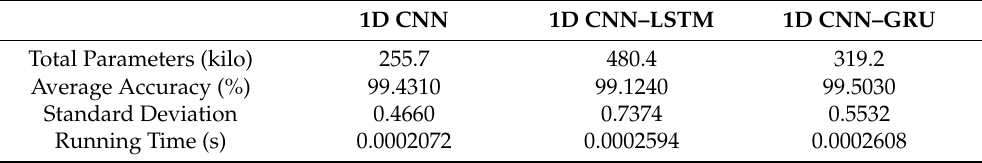
Table 7. The classification results of the optimized 1D CNN-based networks using this paper’s dataset. 1D CNN 1D CNN–LSTM 1D CNN–GRU Total Parameters (kilo) 255.7